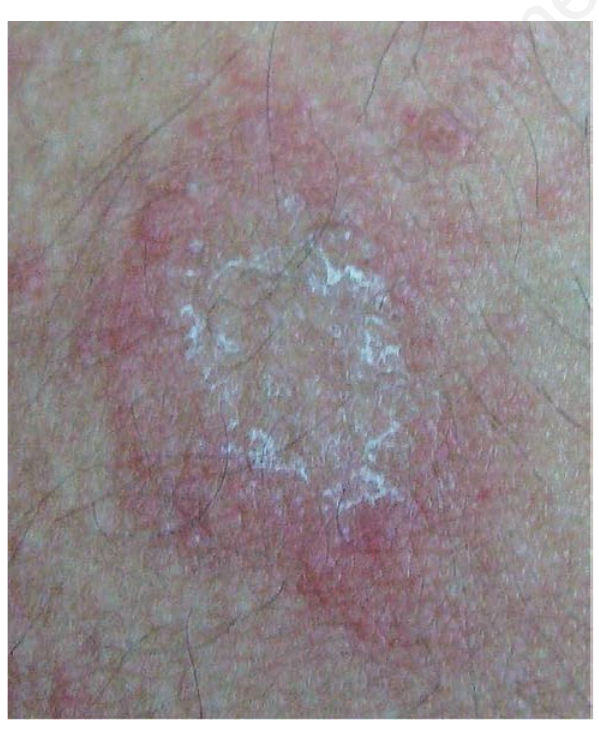
Figure 2. Monomorphous papules on the forearm of a patient with Gianotti-Crosti syndrome, also known as papular acroder- matitis of